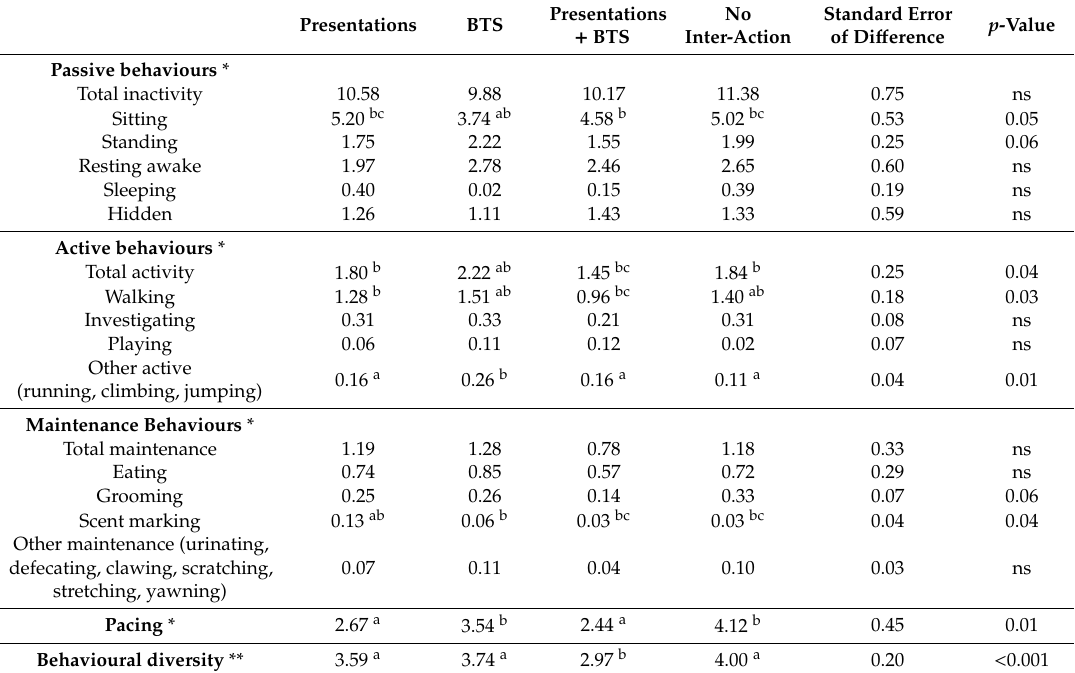
Table 4. E ff ect of treatment on serval